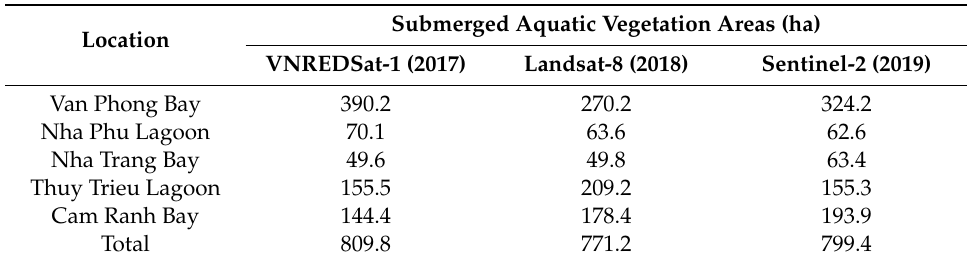
Table 9. SAV areas in Khanh Hoa coastal subsections, determined using data from three satellites. Location